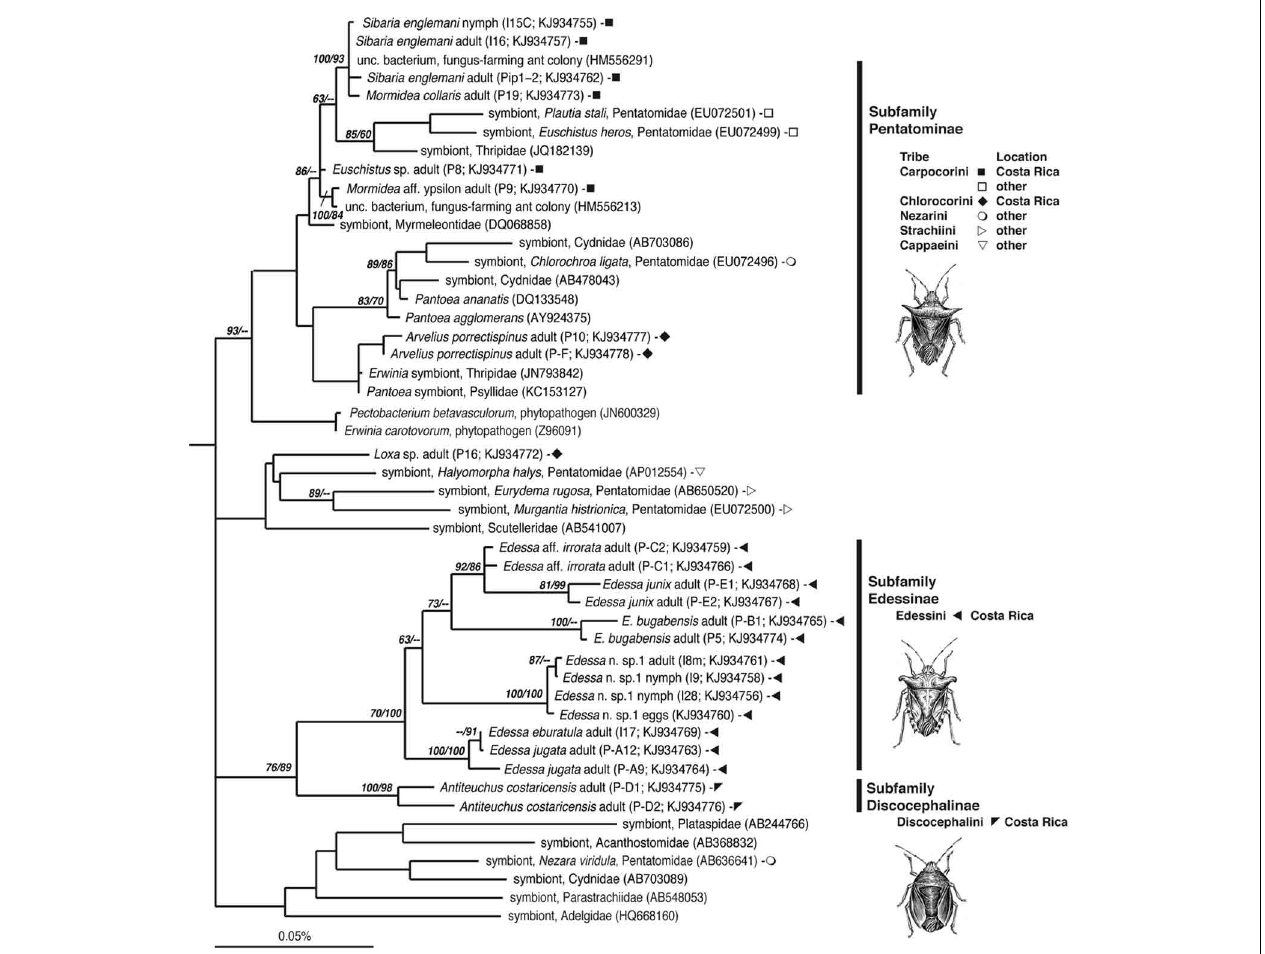
FIGURE 2 | Phylogenetic relationships of gammaproteobacteria associated with Pentatomids examined in this study, based on sequence divergence within the 16S rRNA gene. Additional sequences were obtained from GenBank and compiled and aligned with our 16S rRNA sequences from Costa Rican insects (shown as filled symbols), using the ARB automated